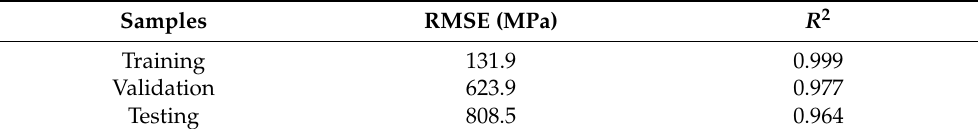
Figure 12. Illustration for one failure pattern of matrix and interface. Table 3. Performance of the trained FFNN for fiber diamond distribution model. Table 3. Performance of the trained FFNN for fiber diamond distribution model.